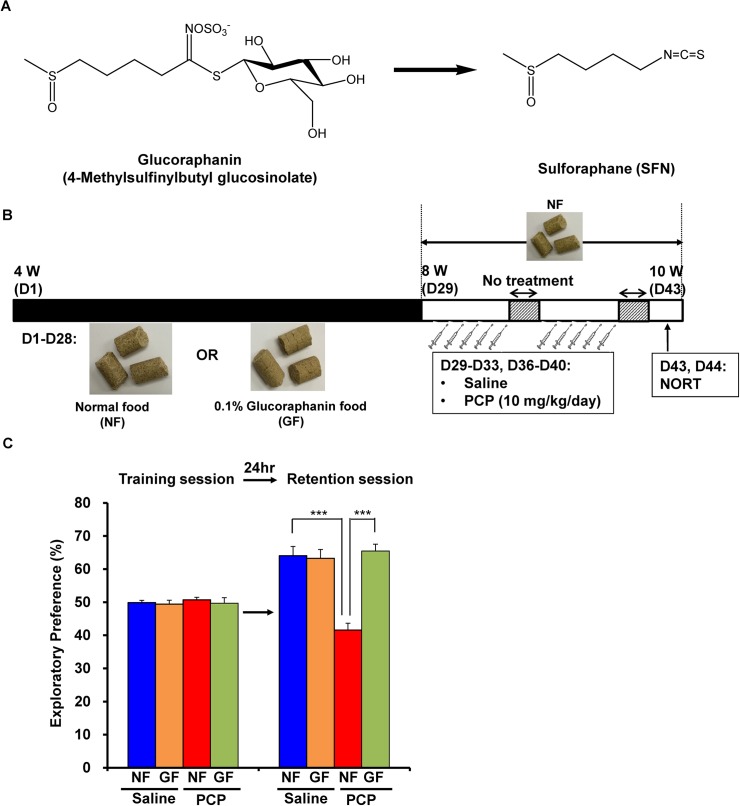
Prophylactic effect of dietary GF food during juvenile and adolescence on PCP-induced cognitive deficits in mice at adulthood.(A): Chemical structure of glucoraphanine (GF) and sulforaphane (SFN). Glucoraphanine (GF) is metabolized to SFN in the body. (B): Schedule of treatment and NORT. From days 1 (4-week olds)– 28 (8-week olds), normal food (NF) or 0.1% GF food (GF) was administered into mice. From days 29 (8-week olds), normal food was administered to all mice. Subsequently, saline (10 ml/kg/day) or PCP (10 mg/kg/day) was administered from days 29–33 and days 36–40. On day 43 and 44, NORT was performed. (C): Dietary 0.1% GF food during days 1–28 significantly attenuated PCP-induced cognitive deficit in mice at adulthood (10-week olds). The data show the mean ± S.E.M. (n = 10–12). ***P < 0.001, N.S. not significant.